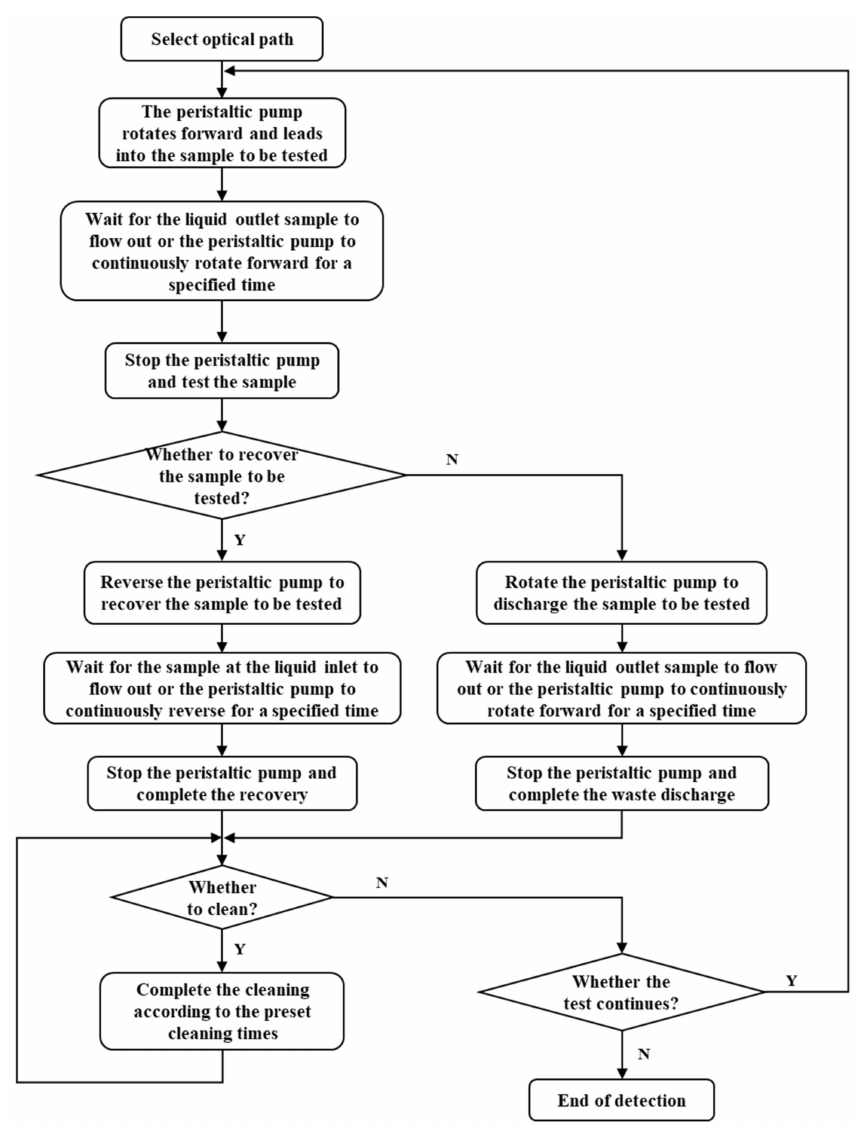
Figure 6. PLC logic control